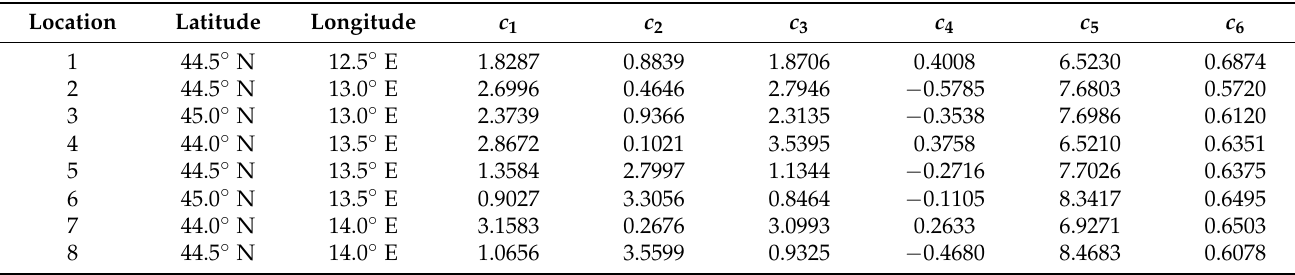
Table A11. Model parameters for joint distribution of u w and Hs per